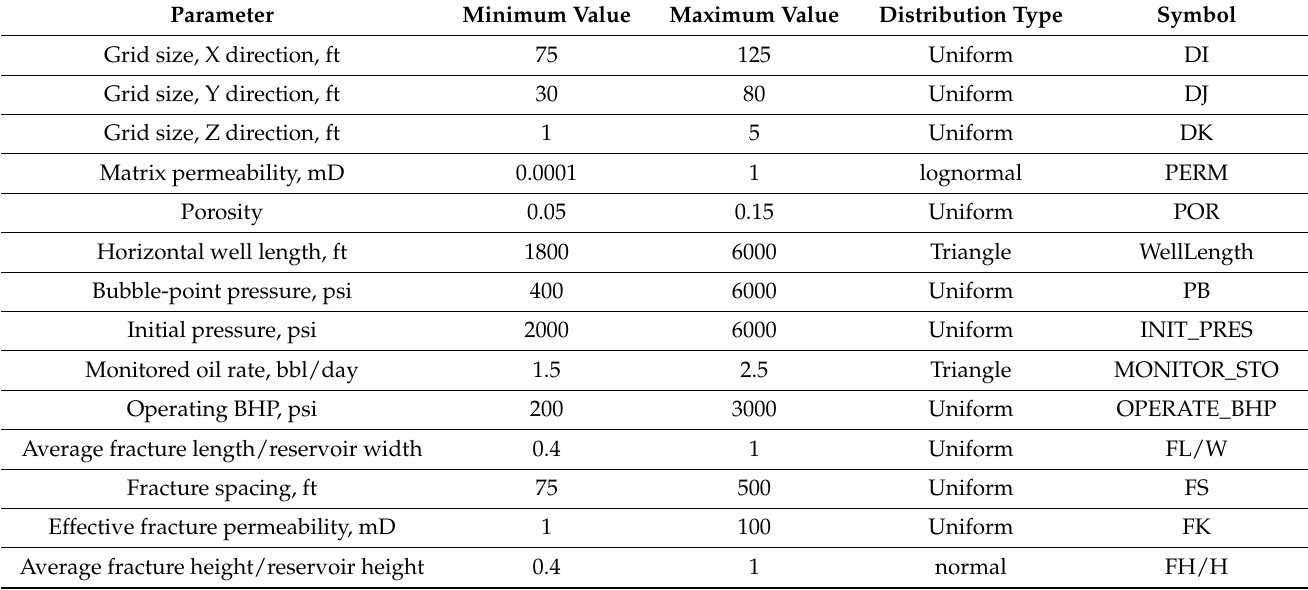
Table 1. Parameters and associated distribution to generate the input data